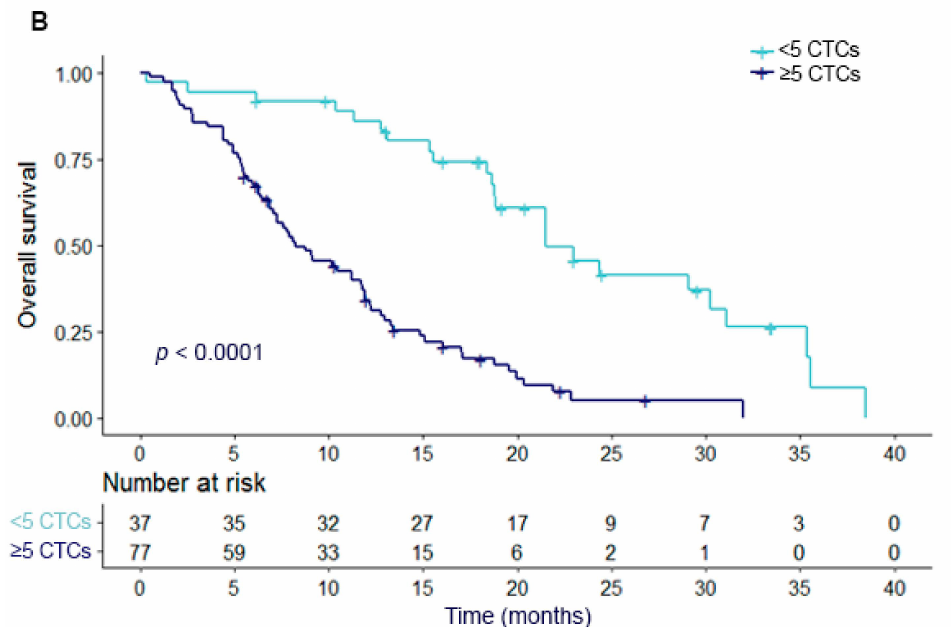
Figure 1. PFS and OS in relation to dichotomized CTC count at baseline. Kaplan Meier curves of ( A ) progression-free survival (PFS) and ( B ) overall survival (OS) in relation to circulating tumor cell (CTC) count at baseline. CTC counts are divided into two categories of < 5 CTCs and ≥ 5